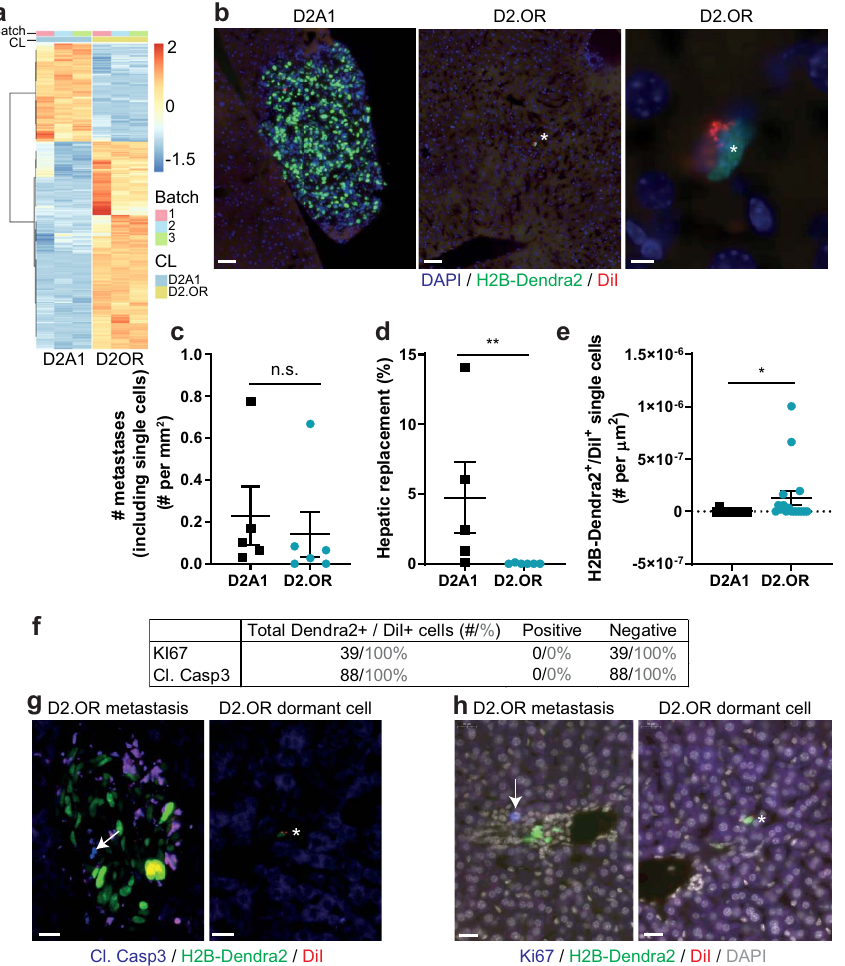
Fig. 1 Dormancy of the D2.OR cells in liver parenchyma of syngeneic mice. a Heatmap of differentially expressed genes between D2.OR and D2A1 cells cultured in 2D. A total of 1619 genes were selected, based on FC > 1.5, no batch inconsistencies, and a Bonferroni correction for multiple testing >0.05. CL = cell line. Batch = replicate. b Microscopy images of D2A1 or D2.OR cell (clusters) in the liver of mice two weeks after intramesenteric vein (i.mes) injection. Scale bar, 50 μ m (left and middle) or 5 μ m (right). Analysis of c metastasis number (including single cells), d hepatic replacement by tumor cells, or e dormant cells in liver sections of mice sacri fi ced two weeks after i.mes injection. n ≥ 5 mice, three sections per mouse. f Quanti fi cation (black: number of cells, gray: percentage) of immunostaining on dormant cells in sections with D2. OR cells. g, h Representative images of D2.OR metastases and dormant cells (indicated by asterisk) stained for cleaved caspase-3 ( g ) or KI67 ( h ). Staining is indicated in blue (arrow). Scale bars, 20 μ m. N = 6 mice, three sections per mouse. Indicated P values were calculated using Mann – Whitney tests. Error bars,